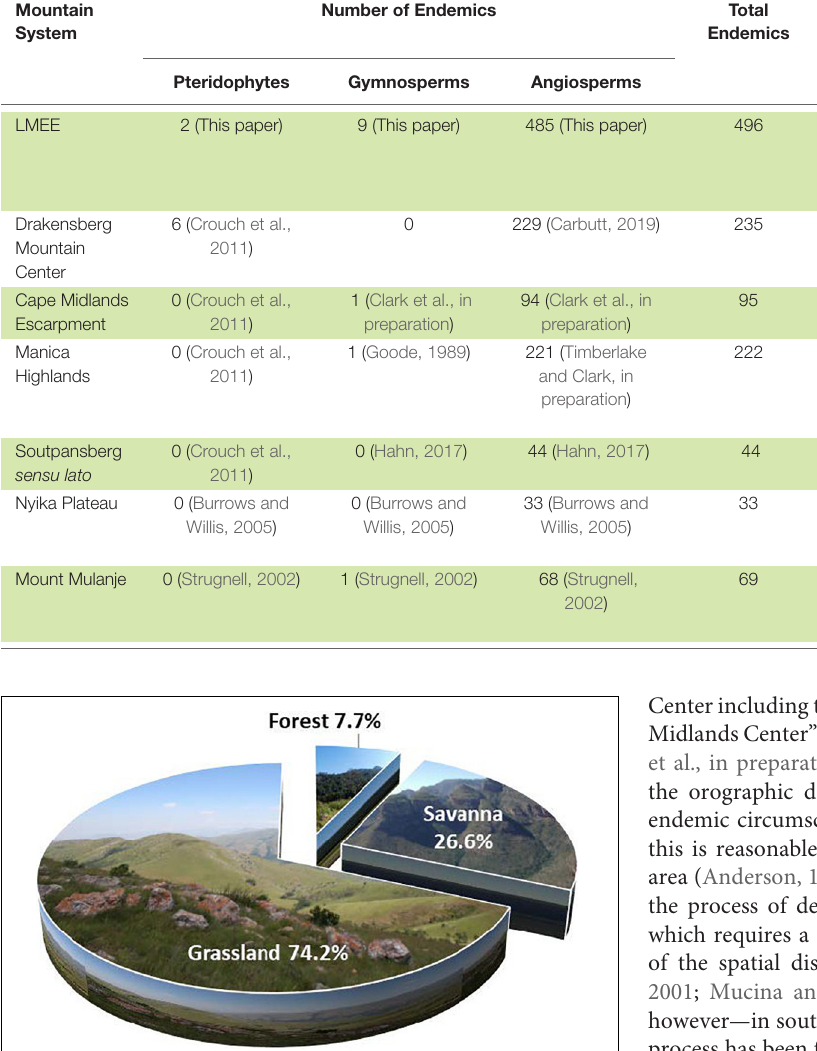
TABLE 2 | Selected comparison of Limpopo–Mpumalanga–Eswatini Escarpment (LMEE) floral endemism with that of other mesic southern African mountains, arranged in descending order of areal extent. Mountain System